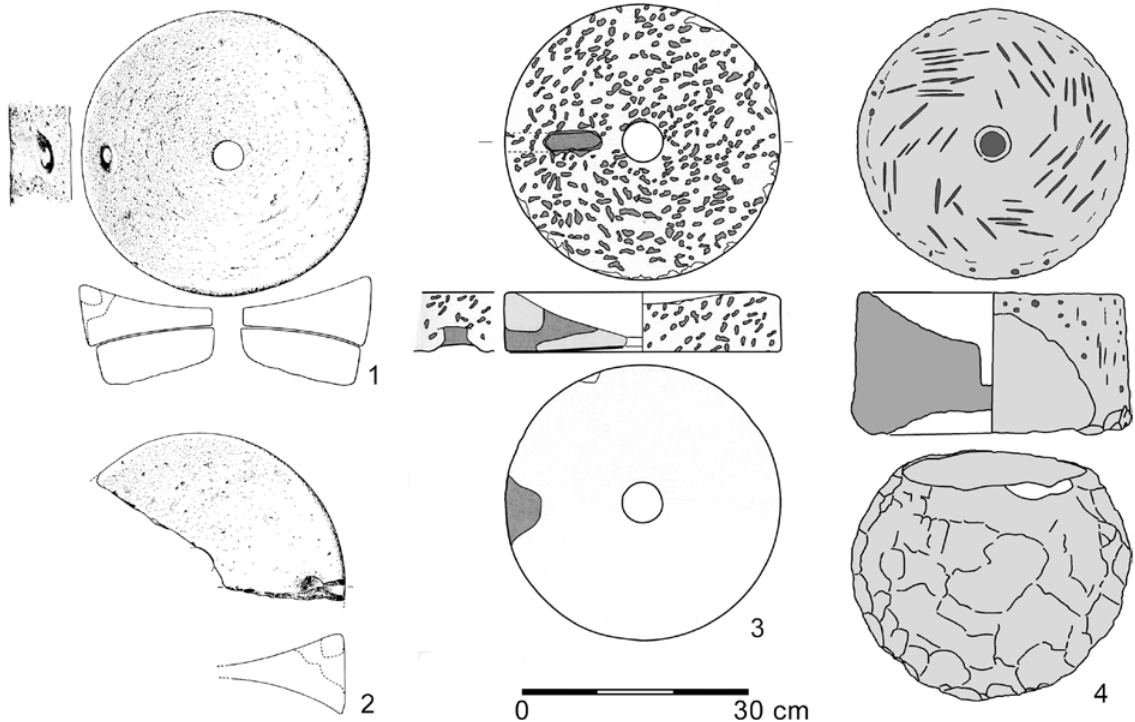
Figure 3. Quernstones of Brillerij type. 1: upper and lower stone, 2-3: upper stones, 4: roughout for upper stone. Provenances: 1. Brillerij; 2. Rasquert; 3. Tongeren, Bilzersteenweg; 4. Mayen or environs. (1-2. Harsema 1967: fig. 5:1-1a.3; 3. Hartoch et al . 2015: fig.